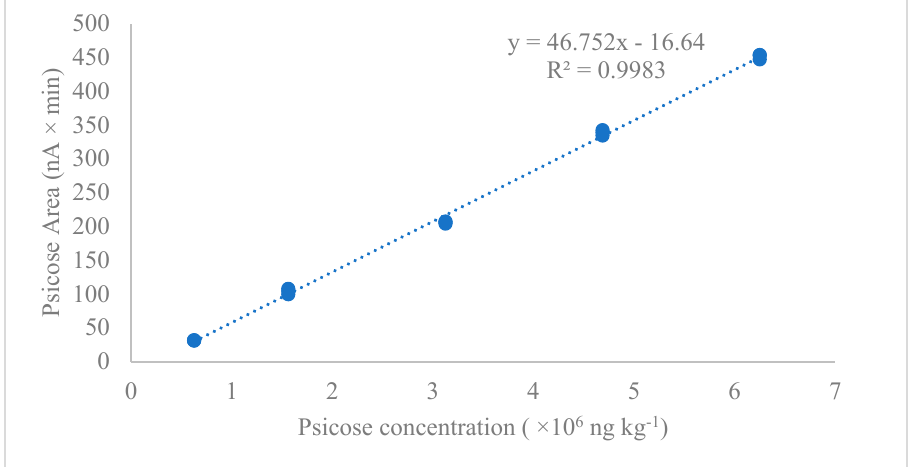
Figure 5. HPAEC − PAD calibration curve of D-psicose.